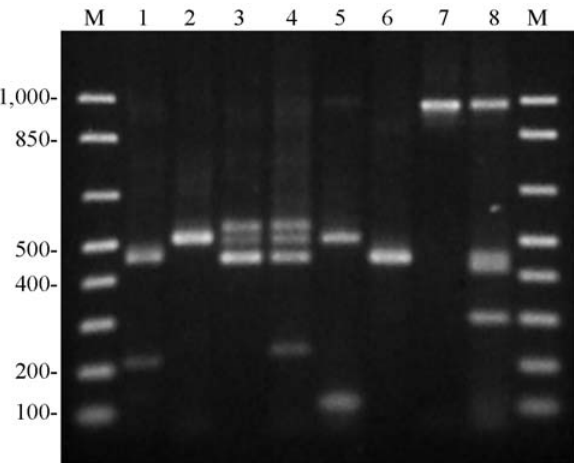
Figure 2 - Agarose electrophoresis profiles of 5S rDNA-PCR products of Sphyrna lewini (1), Galeocerdo cuvier (2), Carcharhinus obscurus (3), Carcharhinus leucas (4), Carcharhinus limbatus (5), Carcharhinus achronotus (6), Alopias superciliosus (7), Isurus oxynchus (8). M, molec- ular mass marker in